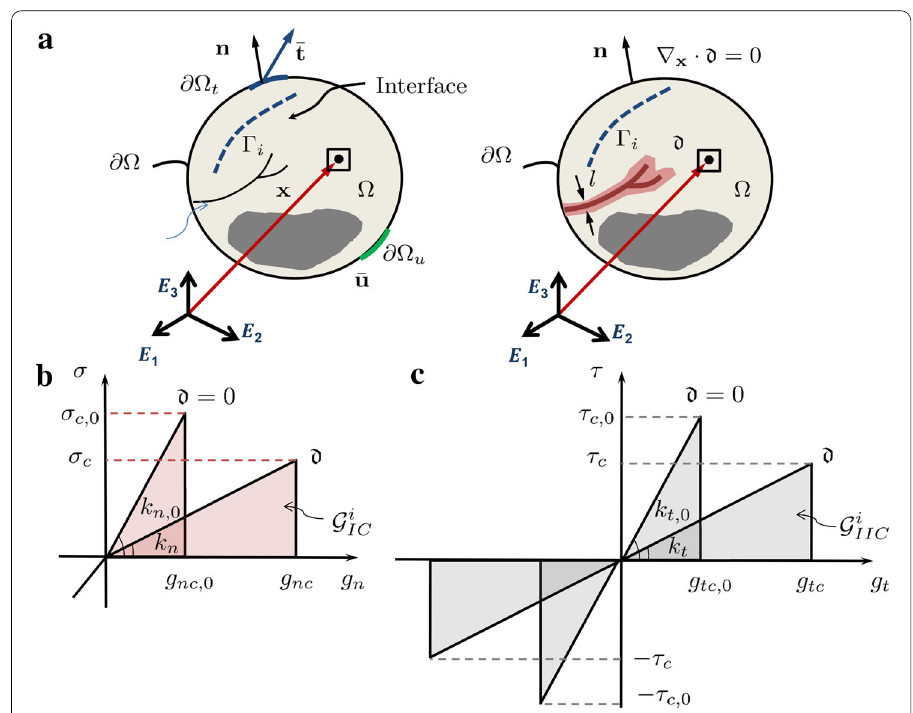
Fig. 2 a Coexistence between brittle fracture in the bulk and cohesive debonding of an interface within the context of the phase field approach of fracture. Schematic representation of the traction separation law of